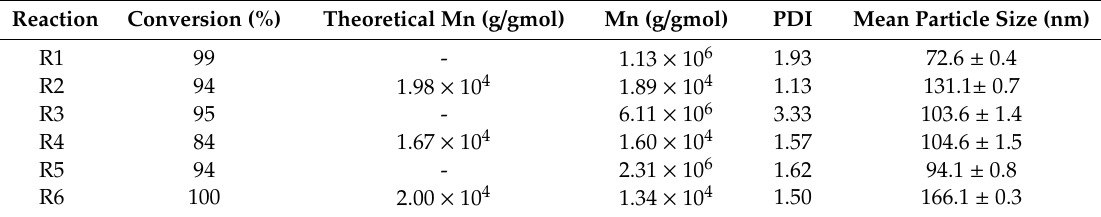
Table 2. Conversion (%), number-average molar mass (Mn), polydispersity (PDI) and after particle size of final polymer products obtained after 300 min of